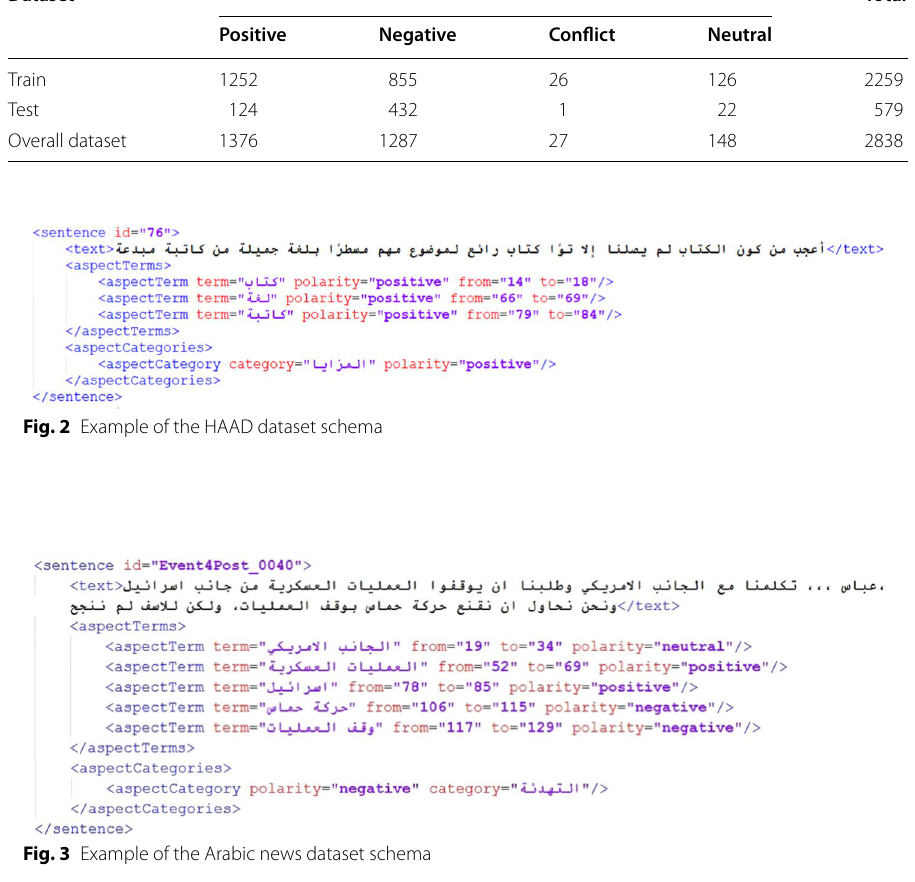
Table 1 Analysis of the HAAD dataset’s aspect terms and polarities Dataset